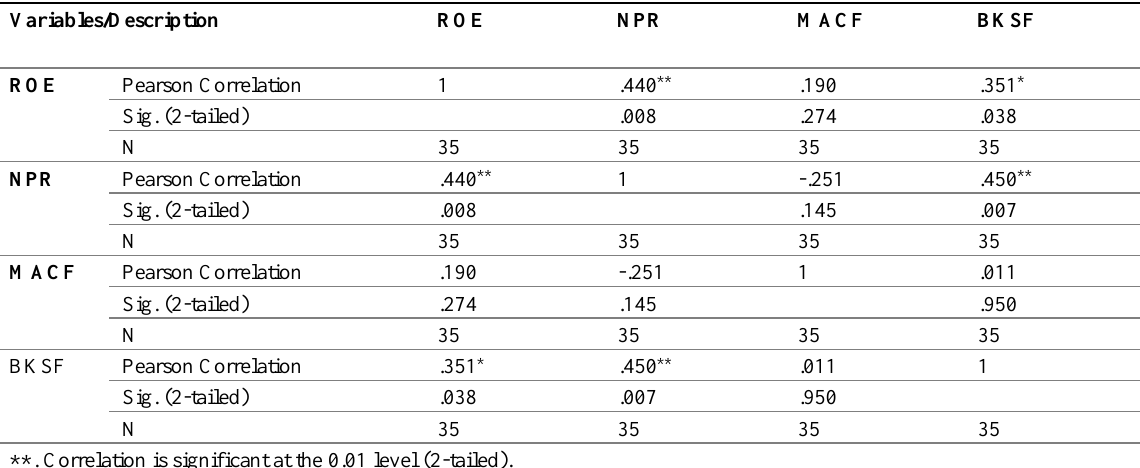
Table 1: Result of Correlation Analysis of Main Variables